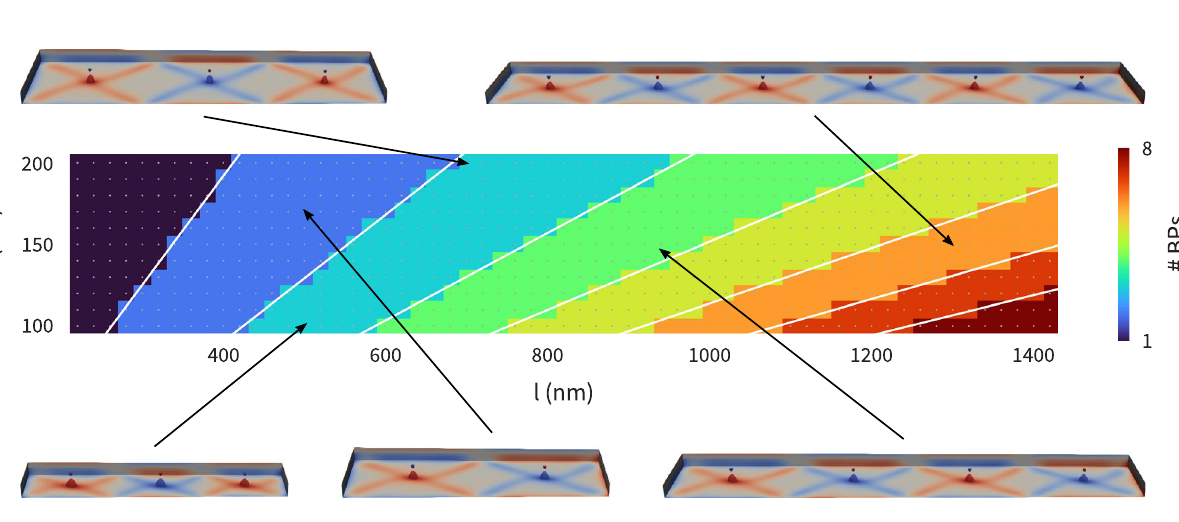
Figure 4. Parameter-space diagram showing the energetically most favourable Bloch point number as a function of length l and width w . All configurations contain Bloch points of alternating opposite type (so the micromagnetic configurations do not contain additional antivortices). Magnetisation profiles for selected configurations reveal the similarity of the different configurations, isosurfaces show m z = ± 0.9